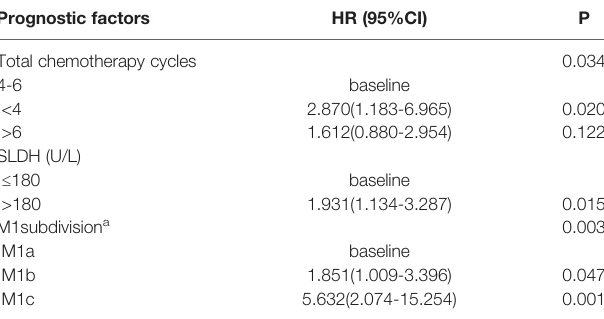
TABLE 6 | Multivariate analysis of variables correlated with overall survival. Prognostic factors